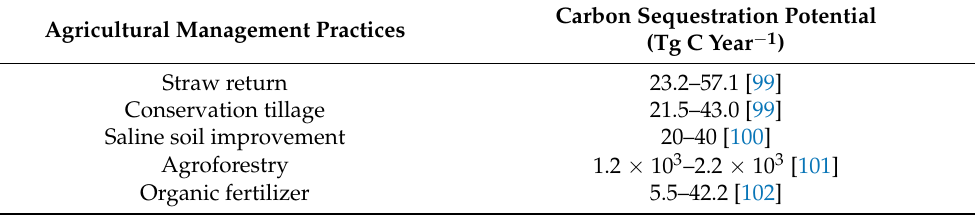
Table 1. Estimation of potentials for agricultural carbon sequestration by different management